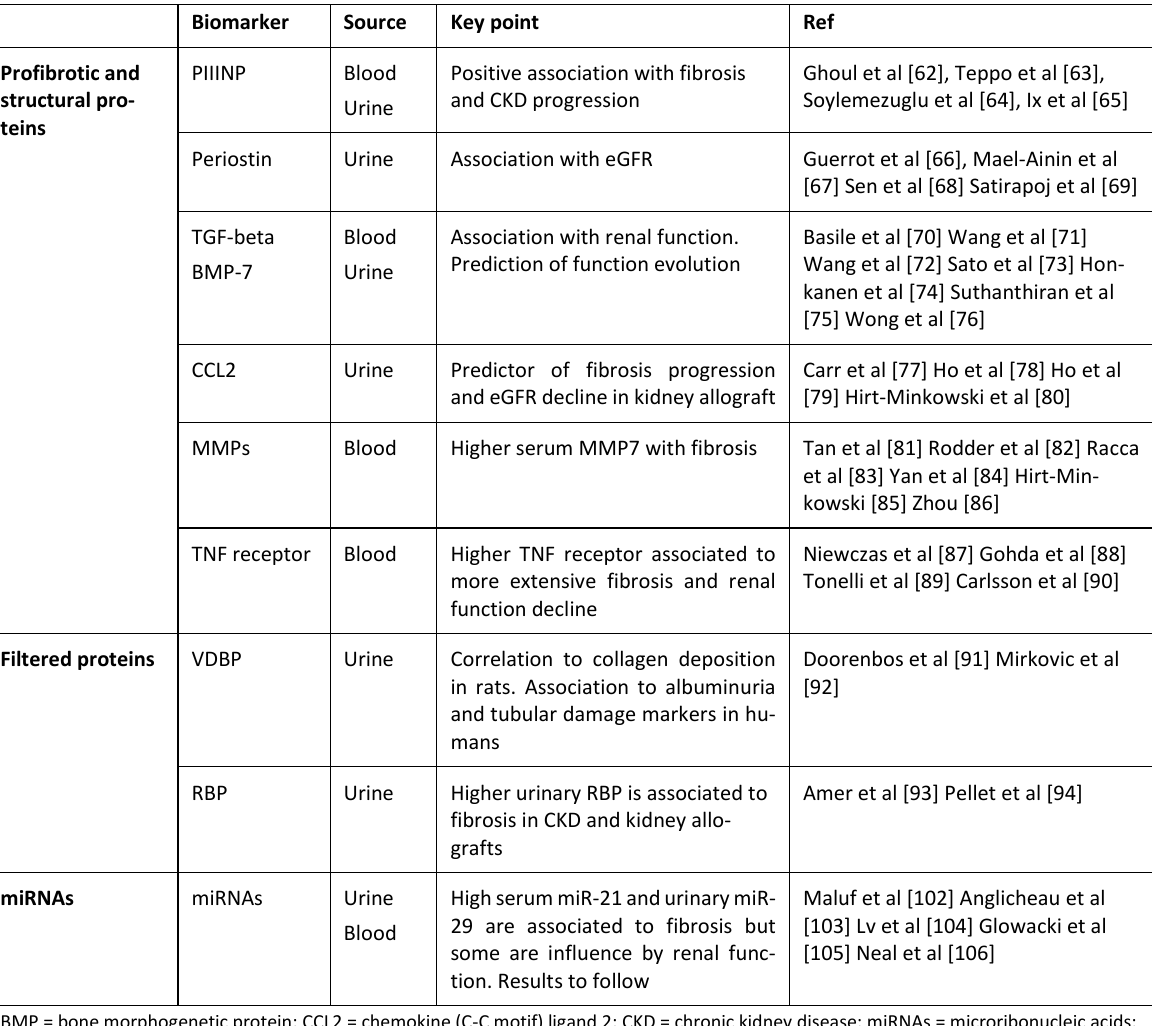
Table 1: Urinary and serum biomarkers of interstitial kidney fibrosis.